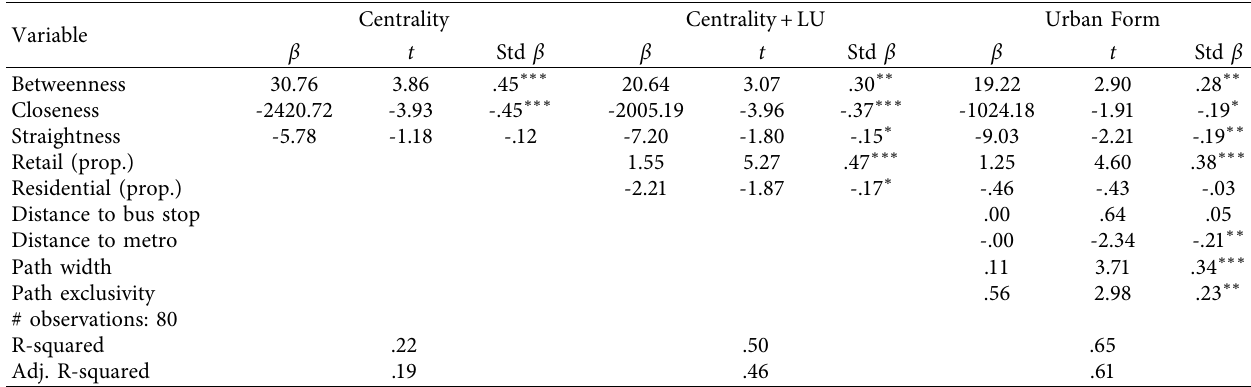
Table 5: Manila-Carriedo: multivariate regression results.